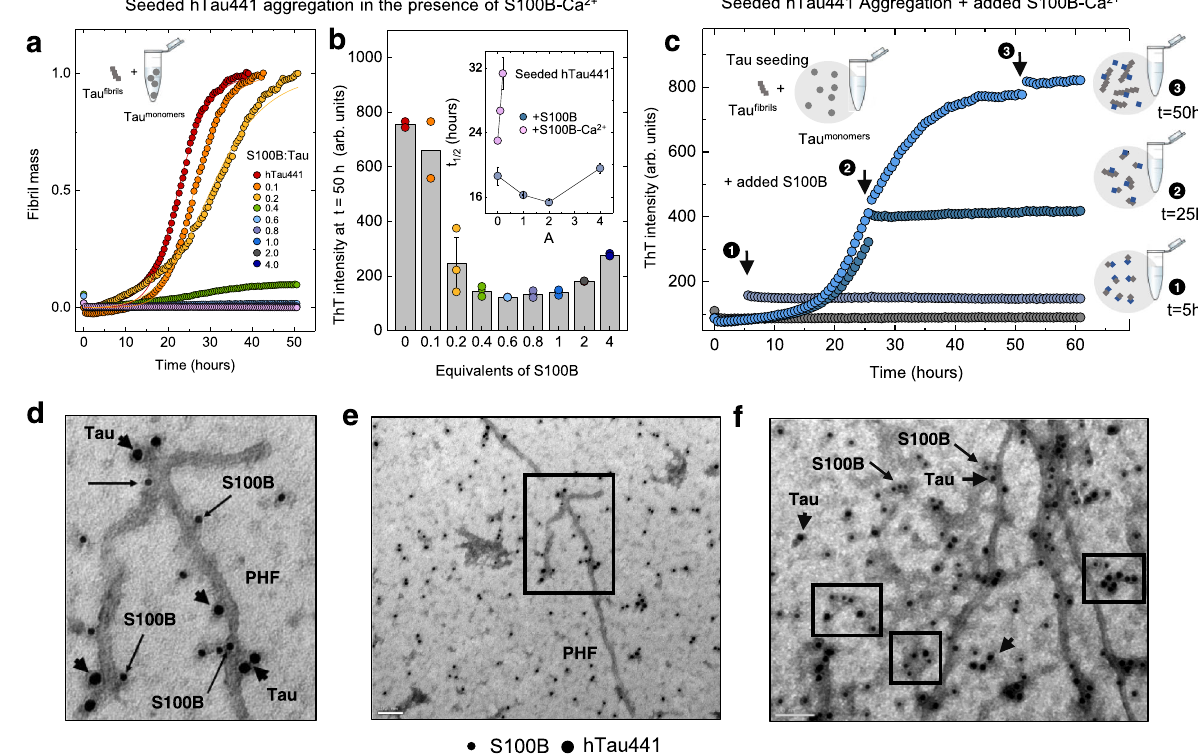
Fig. 5 S100B-Ca 2 + inhibits tau surface-catalyzed secondary nucleation and colocalizes with tau fi brils and oligomers. a Seeded fi bril formation of 10 µ M hTau441 (red) in 50 mM Tris pH 7.4, in the presence of 0.005% of preformed fi brils and 1.1 mM CaCl 2 at 37 °C under agitation, in the presence of 0.1 (orange), 0.2 (yellow), 0.4 (green), 0.6 (light blue), 0.8 (purple), 1.0 (blue), 2.0 (gray), and 4.0 (dark blue) molar equivalents of S100B. b ThT intensity in arbitrary units (arb. units) of the end-time point (same color code) and half-time reaction (inset) of the hTau441-seeded aggregation in the presence (light pink) or the absence (blue) of Ca 2 + , for different S100B molar equivalents. c hTau441-seeded aggregation in the same conditions with addition of equimolar S100B at 0 (gray), 5 (light blue, 1), 25 (dark blue, 2), and 50 (blue, 3) hours after aggregation start. Data are presented as mean values ± SD from n = 3 independent experiments except for samples with 0.0 and 0.1 equivalents of S100B for which n = 2. d – f TEM images of tau aggregates grown in the presence of S100B-Ca 2 + and immunogold labeled against S100B (10 nm, arrow) and tau (15 nm, arrowhead). d Zoom from the black box in e . S100B bound to tau small aggregates and oligomers (boxes in f ). Scale bar 100 nm ( e and f ). Independent experiments of immunogold labeling were performed three